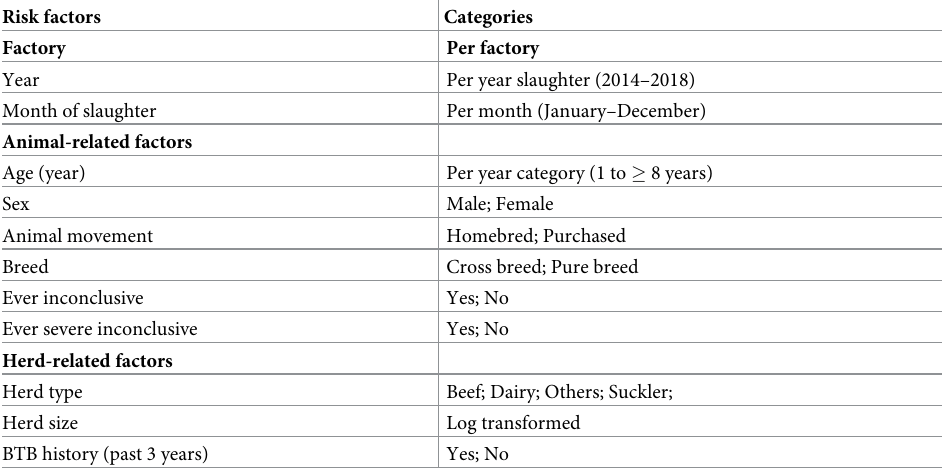
Table 1. Potential risk factors considered to have associations with FL submission and confirmation from animals slaughtered in Irish factories from